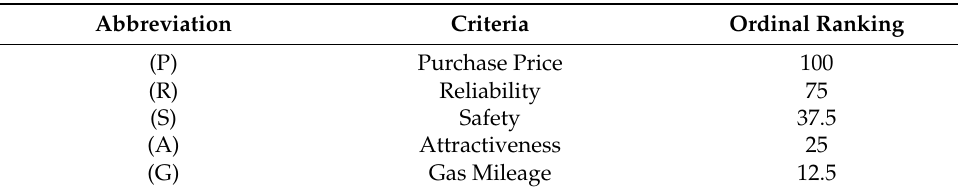
Table 6. Ordinal ranking for SWING.